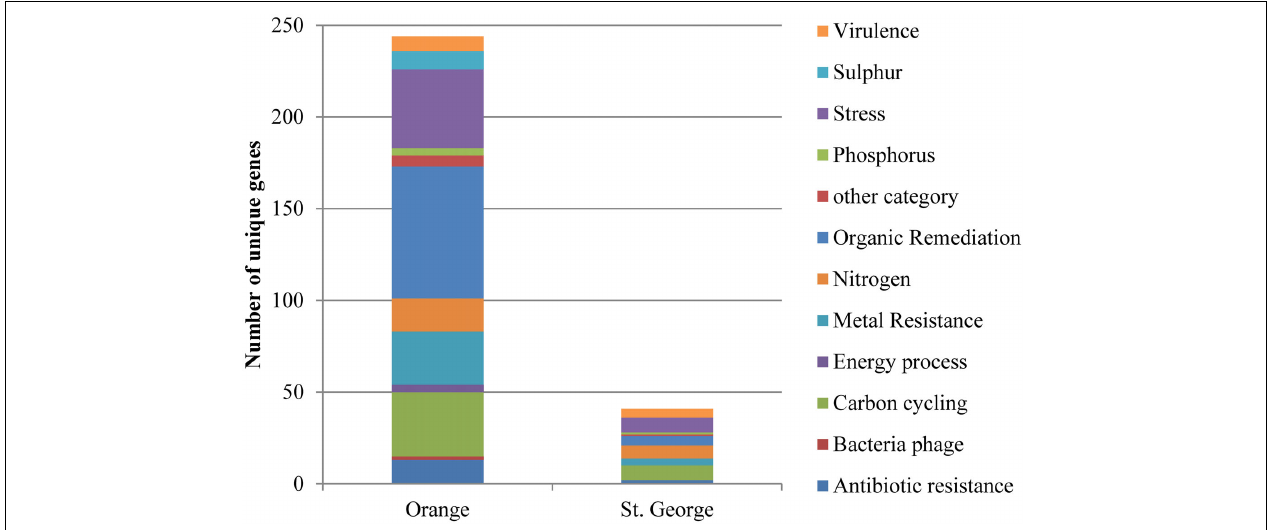
FIGURE 2 | Number of genes in functional gene groups unique to each beach detected by microarray analysis. Genes were represented in the beach site when sands were collected at all three time points (June, August or September, and November 2010).